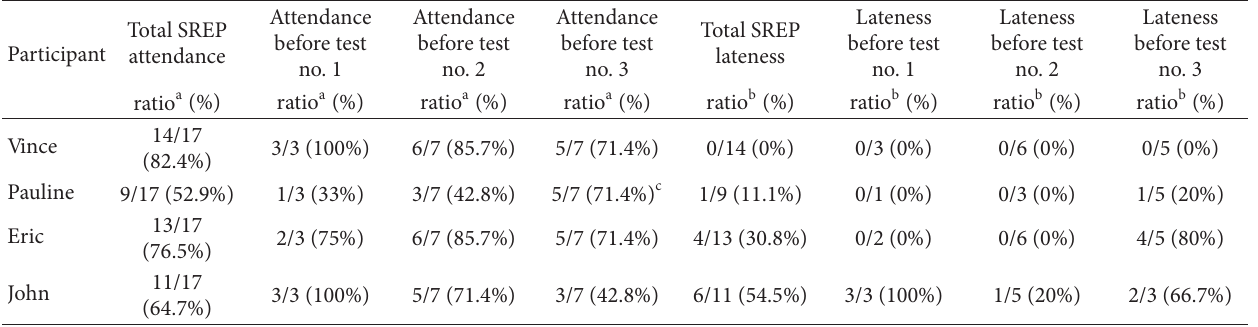
T 3: Student attendance and tardiness during the SREP intervention.